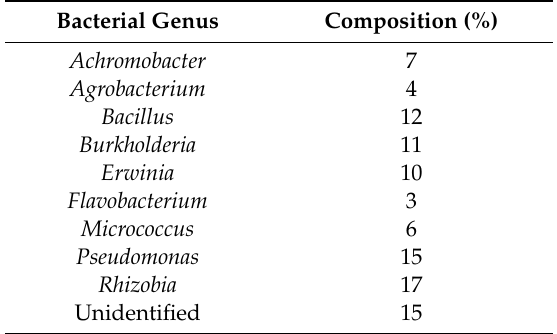
Table 2. Bacterial composition (%) of maize inocula used in the phosphate-solubilizing bacteria study.